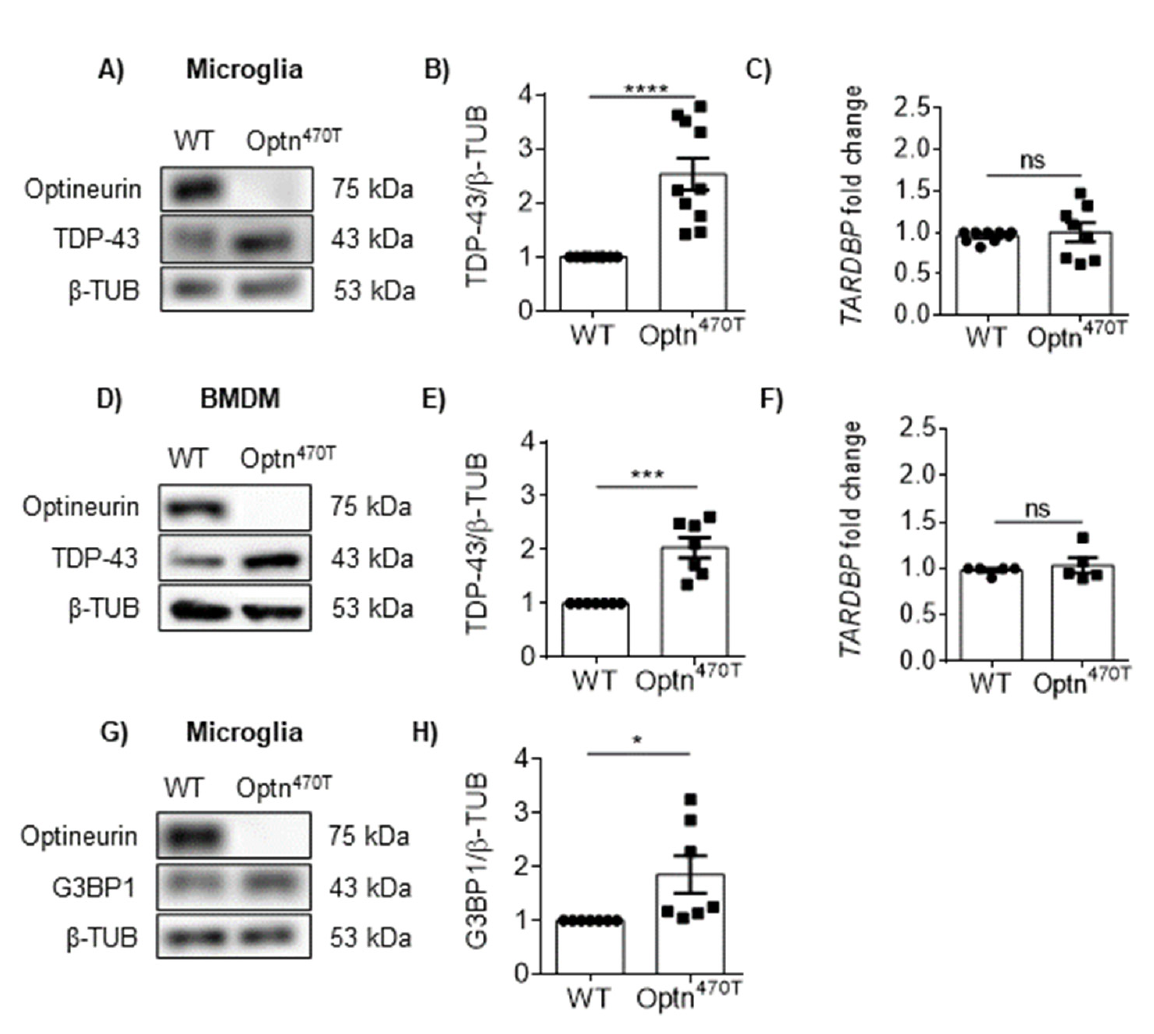
Figure 2. Basal level of TDP-43 is elevated in primary microglia and macrophages carrying the optineurin truncation (Optn 470T ) without changes in mRNA levels. ( A ) Western blotting for TDP-43 and optineurin in WT and Optn 470T primary microglia. ( B ) Bar charts show the densitometric analysis of TDP-43 protein levels normalized to β -tubulin in primary microglia. ( C ) mRNA for TARDBP in WT and Optn 470T microglia was assessed by RT-PCR. ( D ) Western blotting for TDP-43 and optineurin in WT and Optn 470T BMDMs. ( E ) Bar charts show the densitometric analysis of TDP-43 protein levels normalized to β -tubulin in BMDMs. ( C ) mRNA for TARDBP in WT and Optn 470T BMDMs was assessed by RT-PCR. ( G ) Western blotting for G3BP1 in WT and Optn 470T primary microglia. ( H ) Bar charts show the densitometric analysis of G3BP1 protein levels normalized to β -tubulin. An average ± SEM from 5 ( F ), 7 ( B , H ), 9 ( C ), and 10 ( E ) independent experiments is shown. Statistical analysis was performed by Student’s t -test: ns, not significant, * p < 0.05, *** p < 0.001, **** p <